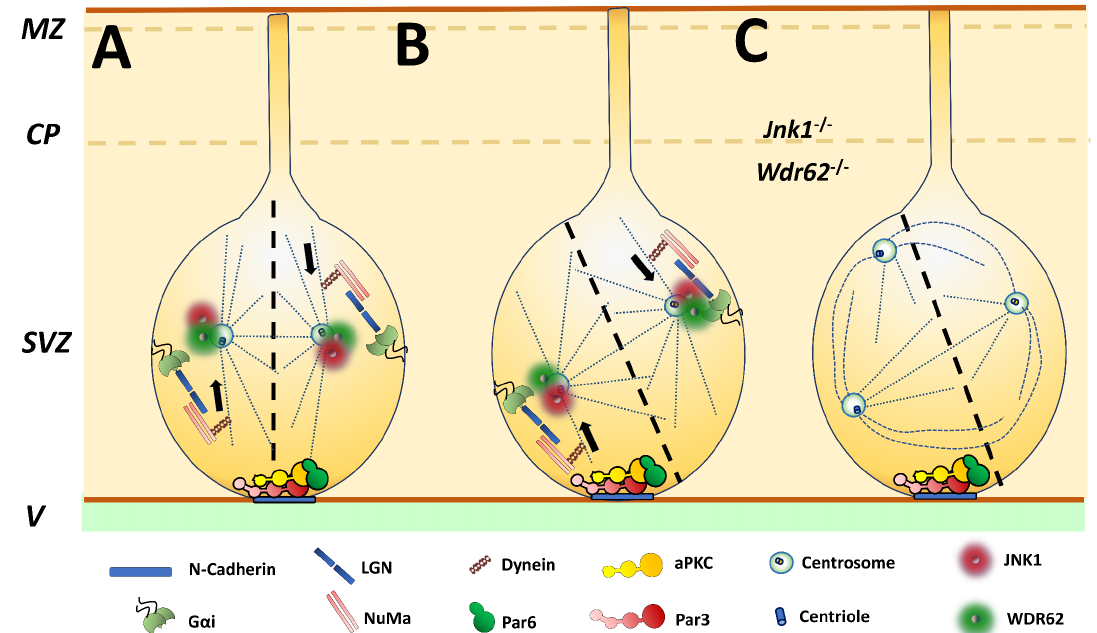
1 Figure 1. JNK1 controls polarization of dividing cells. Radial-glial-like cells (cortical NSCs) are located in the SVZ and show apicobasal polarization. The orientation of the mitotic spindle controls symmetric and asymmetric divisions: ( A ) Symmetric division preserves self-renewal and expands radial glial-like progeny, ( B ) Asymmetric division promotes the loss of apicobasal contact of daughter cells, promoting their di ff erentiation. The activity of the Par3 / Par6 / aPKC and G α i-LGN-NuMa complexes determines the orientation of the mitotic spindle. ( C ) The pericentriolar material of centrosome contains both JNK1 and WDR62. Genetic disabling of this elements induces abnormal spindle formation and aberrant centrosome biogenesis. Adapted from